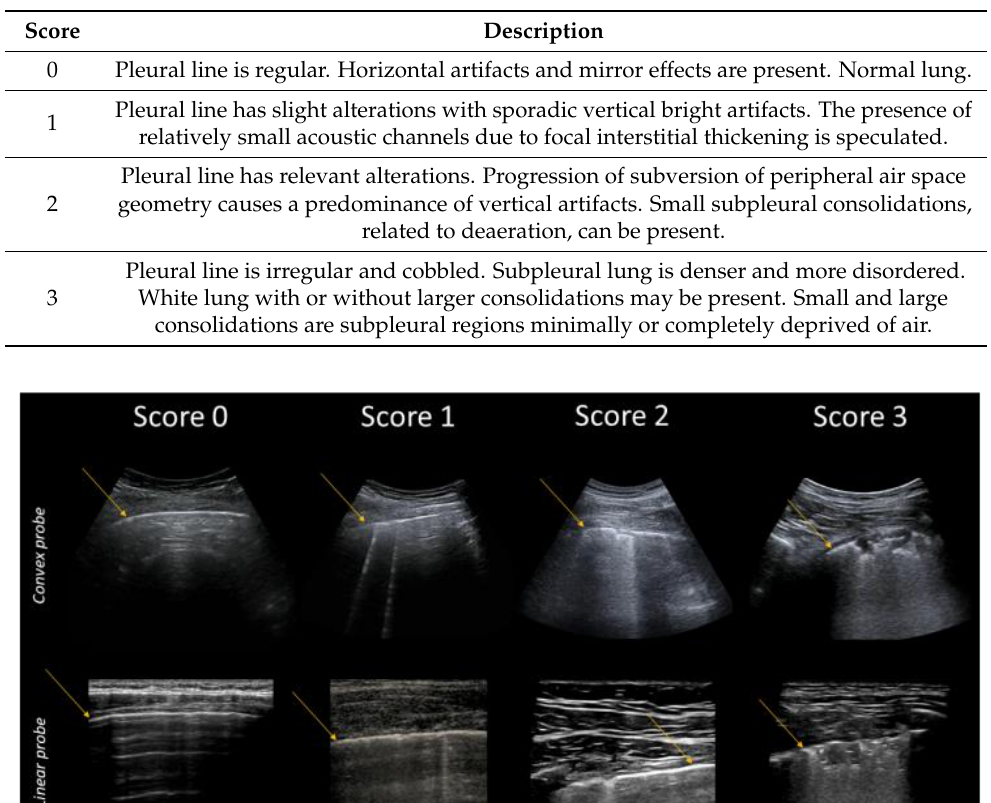
Table 2. COVID-19 Scores.